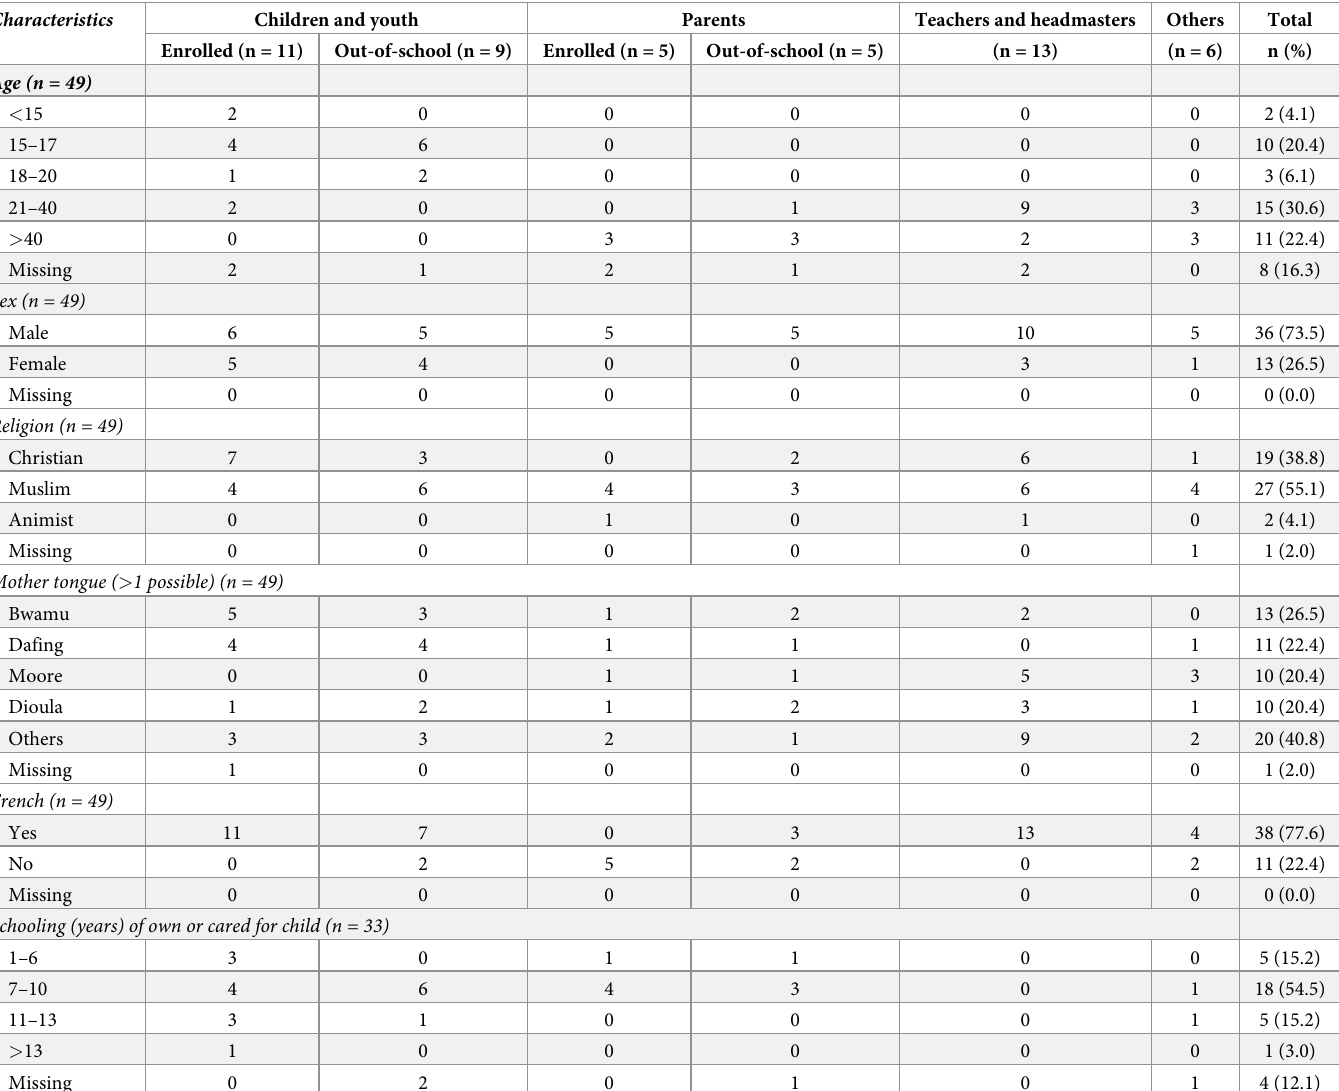
Table 1. Selected characteristics of study respondents ( N =